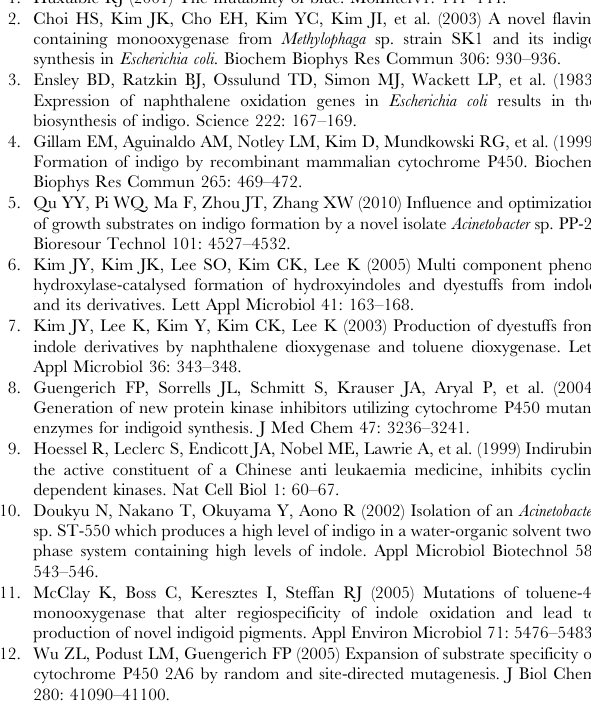
Figure S5 Identification of new purple product derived from indole. A. Mass spectra; B. 1 H NMR spectra; C. 13 C